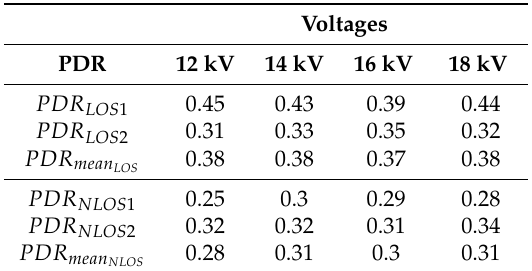
Table 6. Packet delivery ratio for all voltages in different